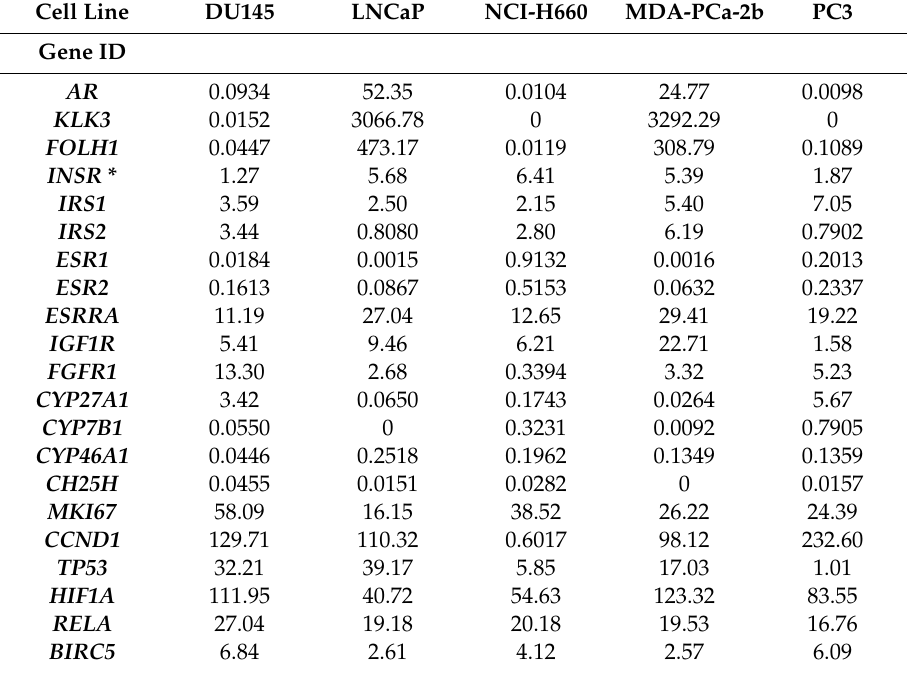
Table 3. RNA sequencing data from https: // www.cbioportal.org /